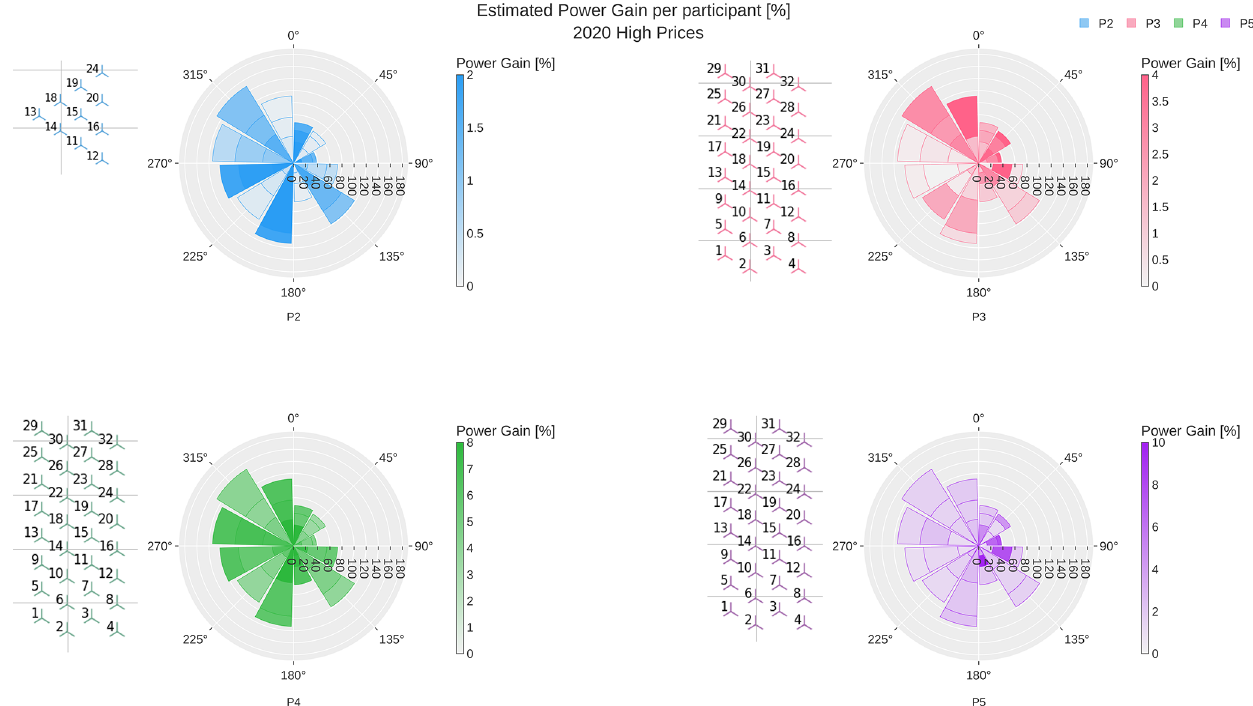
Figure 6. Power gain when using wind farm flow control (WFFC) in simulations with the wind inflow and price information for 2020 as shown in Fig. 1. Each polar plot presents the results of one participant. The wind farm layout considered by this participant is shown on the left side of the polar plot. The estimated increased production per bin is normalised with respect to the production under normal operation without WFFC. For each sector, the stacked gains are indicated as heat maps and reported per 7, 9 and 11ms − 1 along the radial direction, with respect to the number of samples per